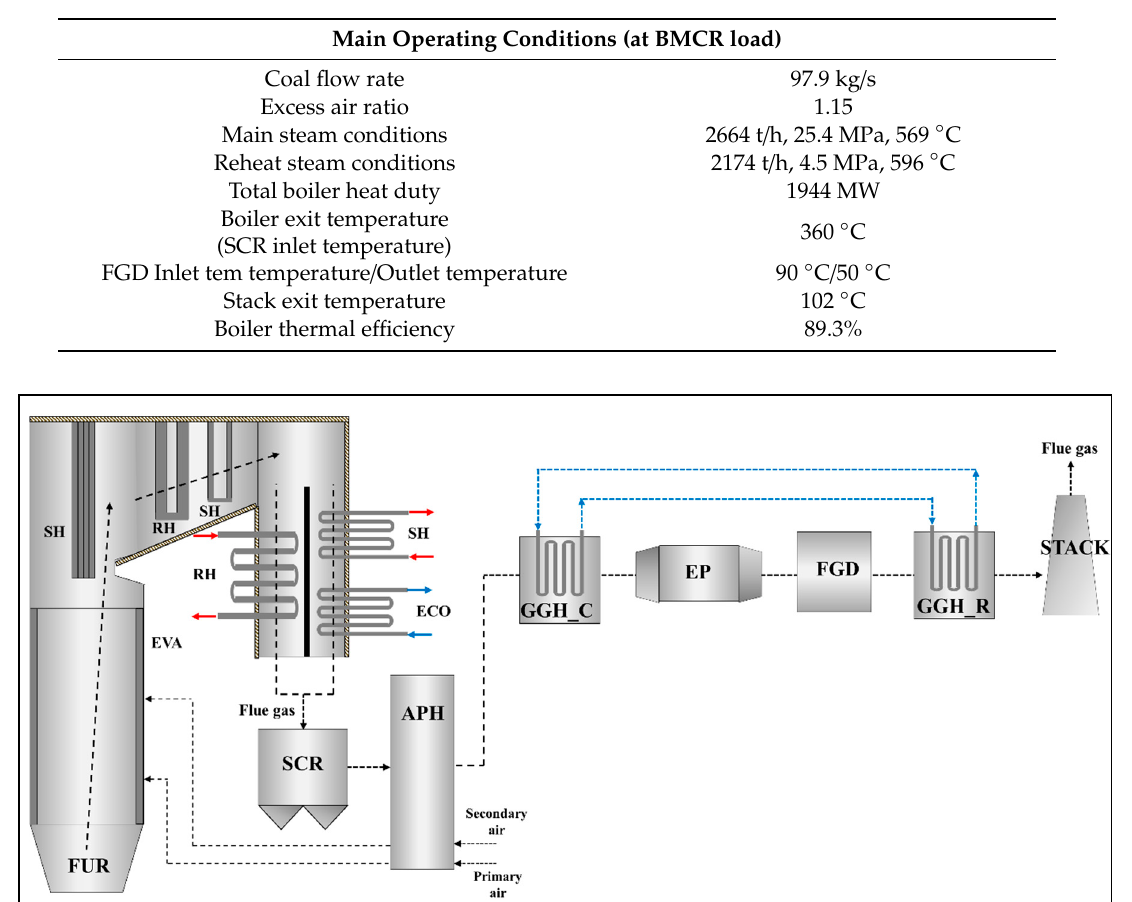
Figure 2. Schematic configuration of components and material flows in the target supercritical coal-fired power plant system (plant capacity: 870 MWe).